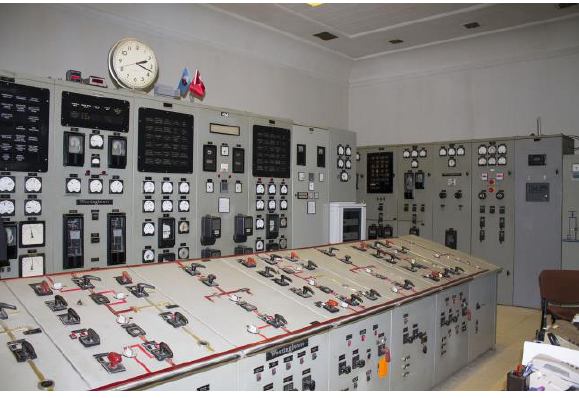
Figure 6. Sarıyar Hydroelectric Plant, control